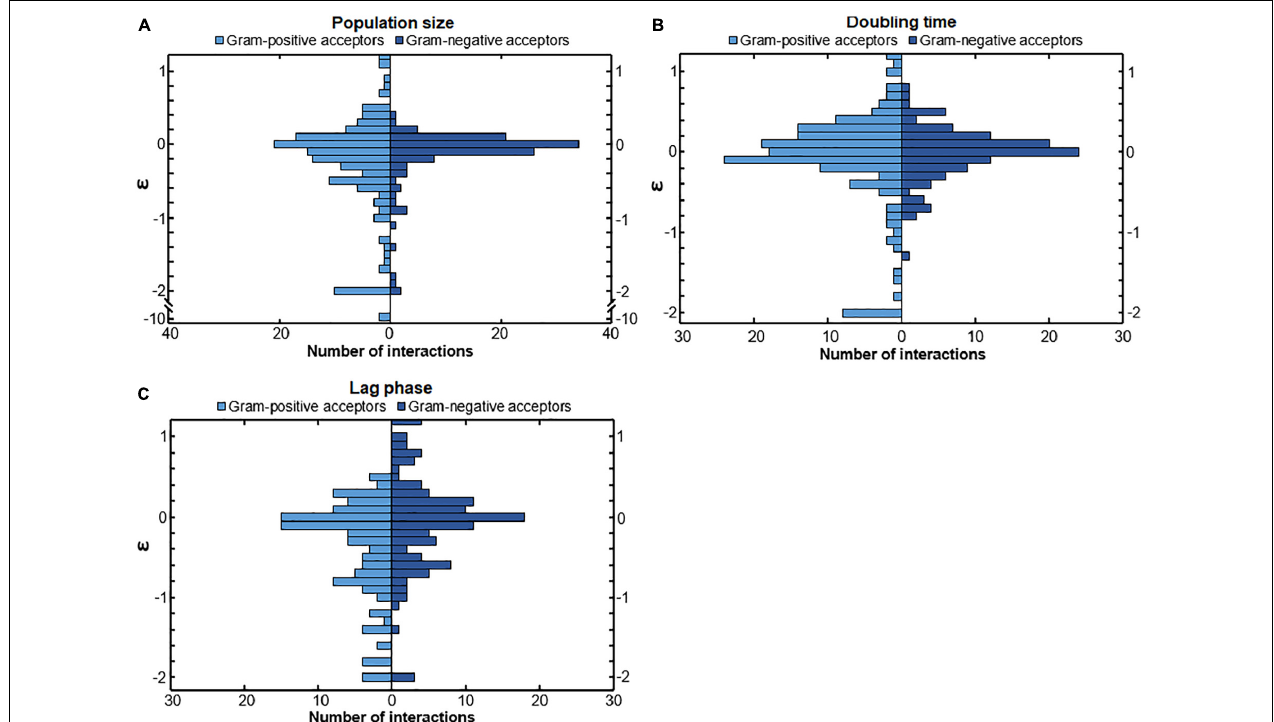
FIGURE 2 | The response of Gram-positive and Gram-negative acceptors. (A) Gram-negative bacteria showed a more conserved response compared to Gram-positive bacteria to conditioned media. The distribution of population size interactions was significantly different for Gram-positive bacteria and Gram-negative bacteria ( p = 0.024), meaning that Gram-positive bacteria overall had a wider range of responses to the conditioned media of the donors (B) The distribution of the doubling time interactions of Gram-positive and Gram-negative acceptors was not significantly different ( p = 0.051), even though Gram-negative bacteria showed a more conserved response with the data points more around the median compared to Gram-positive acceptors. (C) The lag-phase of Gram-negative acceptors was more often positively affected (meaning a shortened lag-phase) compared to Gram-positive acceptors. The distribution of interactions affecting the length of the lag phase was significantly different for Gram-positive and Gram-negative bacteria ( p = 0.0013). Significance of results was calculated using Welch’s unequal variances t